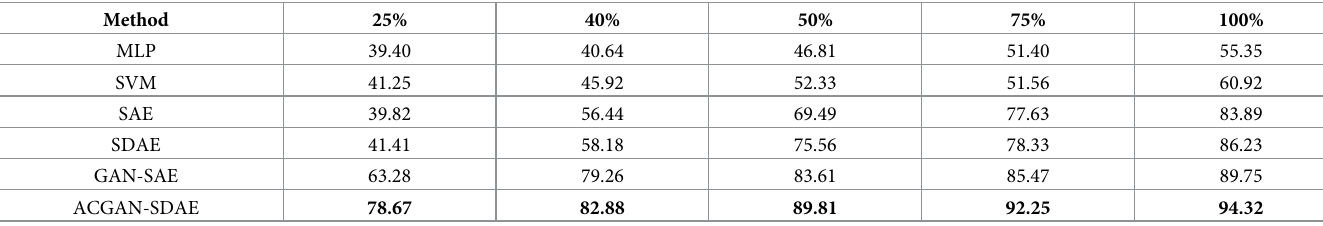
Table 3. Diagnosis accuracy of different models in different fault sample proportions